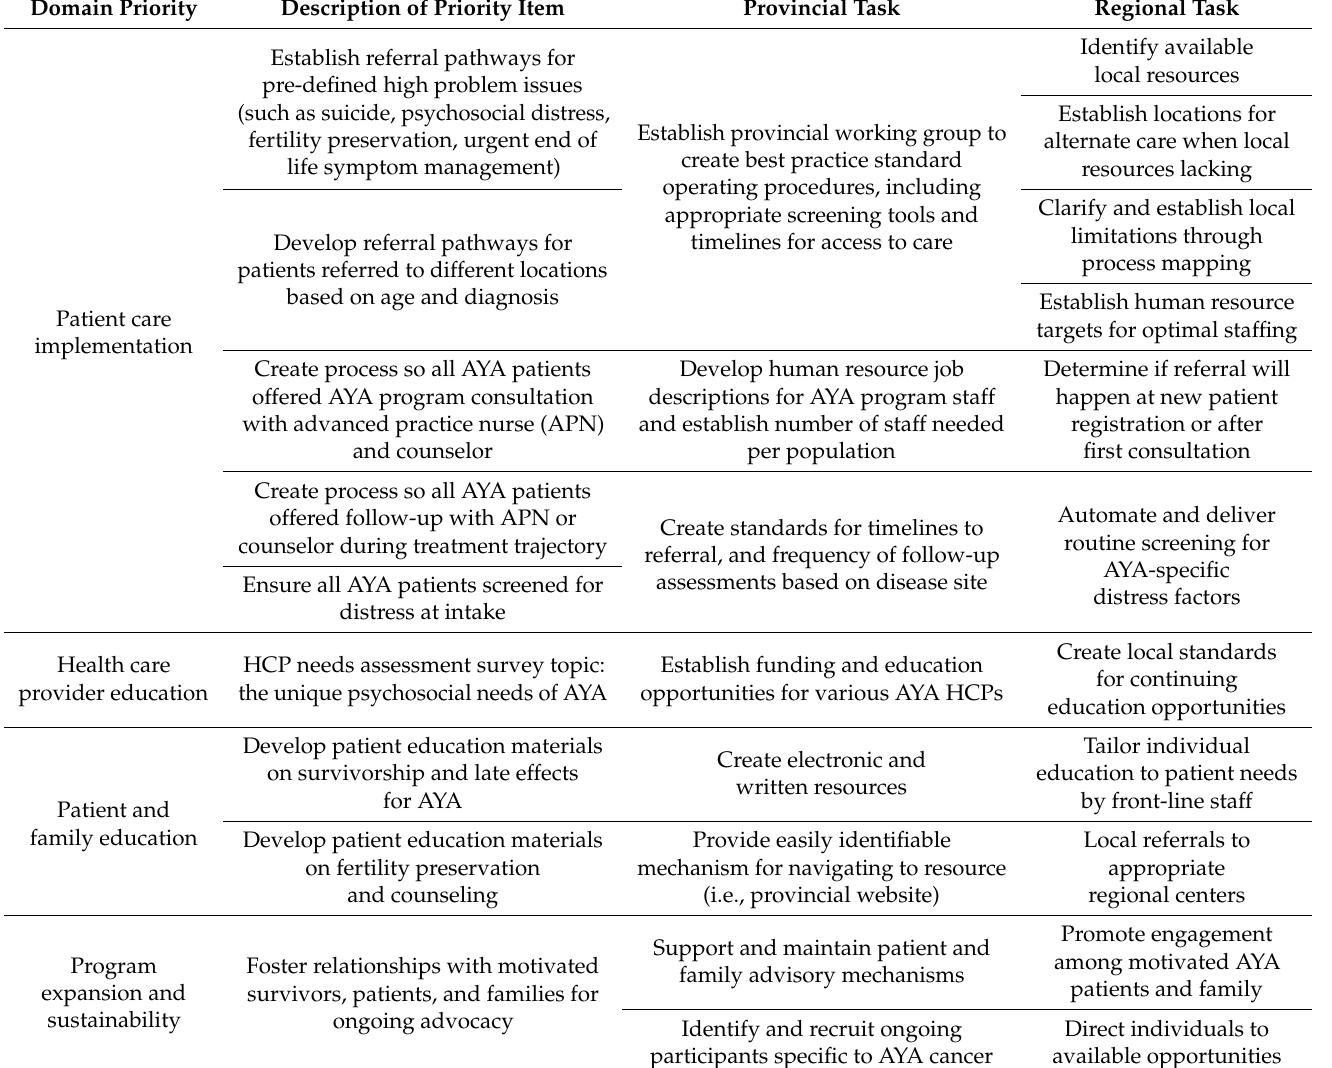
Table 3. Example tasks of the proposed AYA